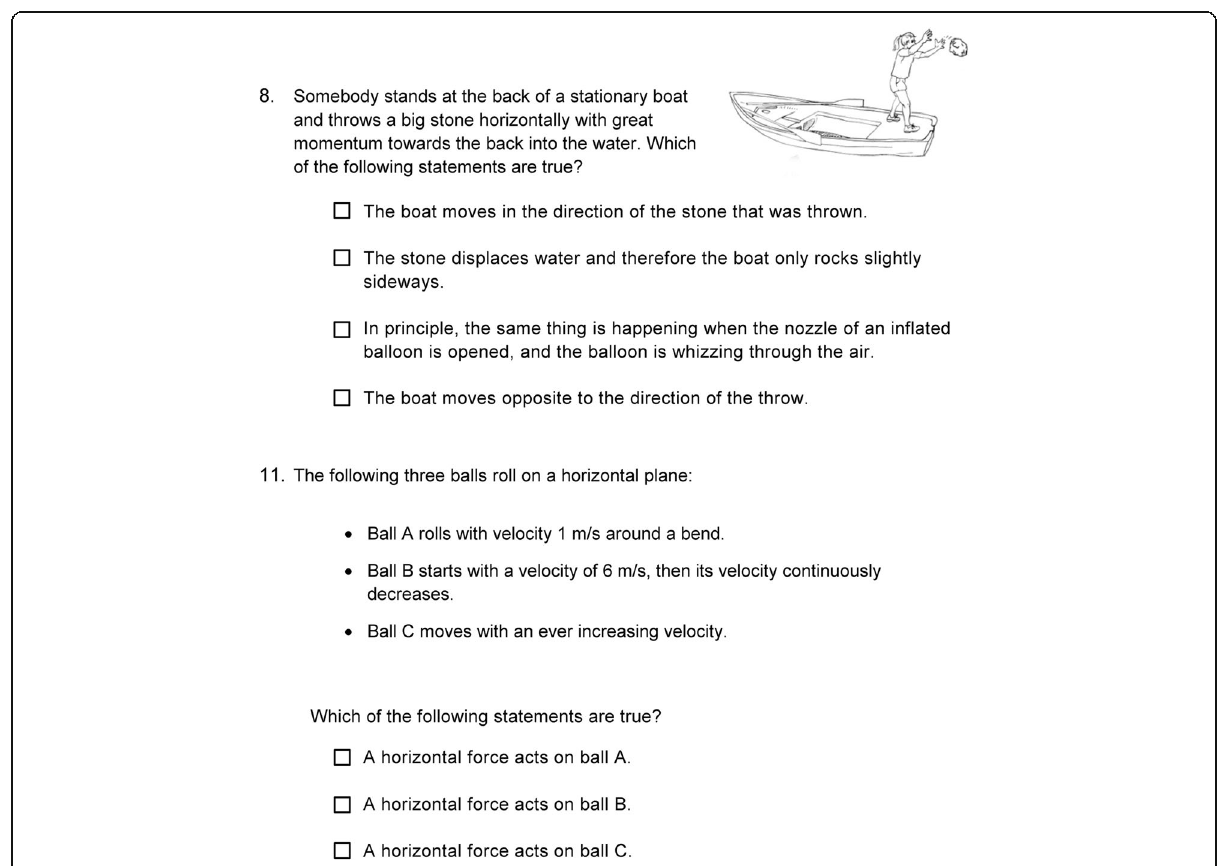
Fig. 2 Two sample items of the Test of basic Mechanics Conceptual Understanding (bMCU) translated into English. For item 8 ( “ Stone ” ), the last two answer alternatives are correct, and for item 11 ( “ Balls ” ), all three answer alternatives are